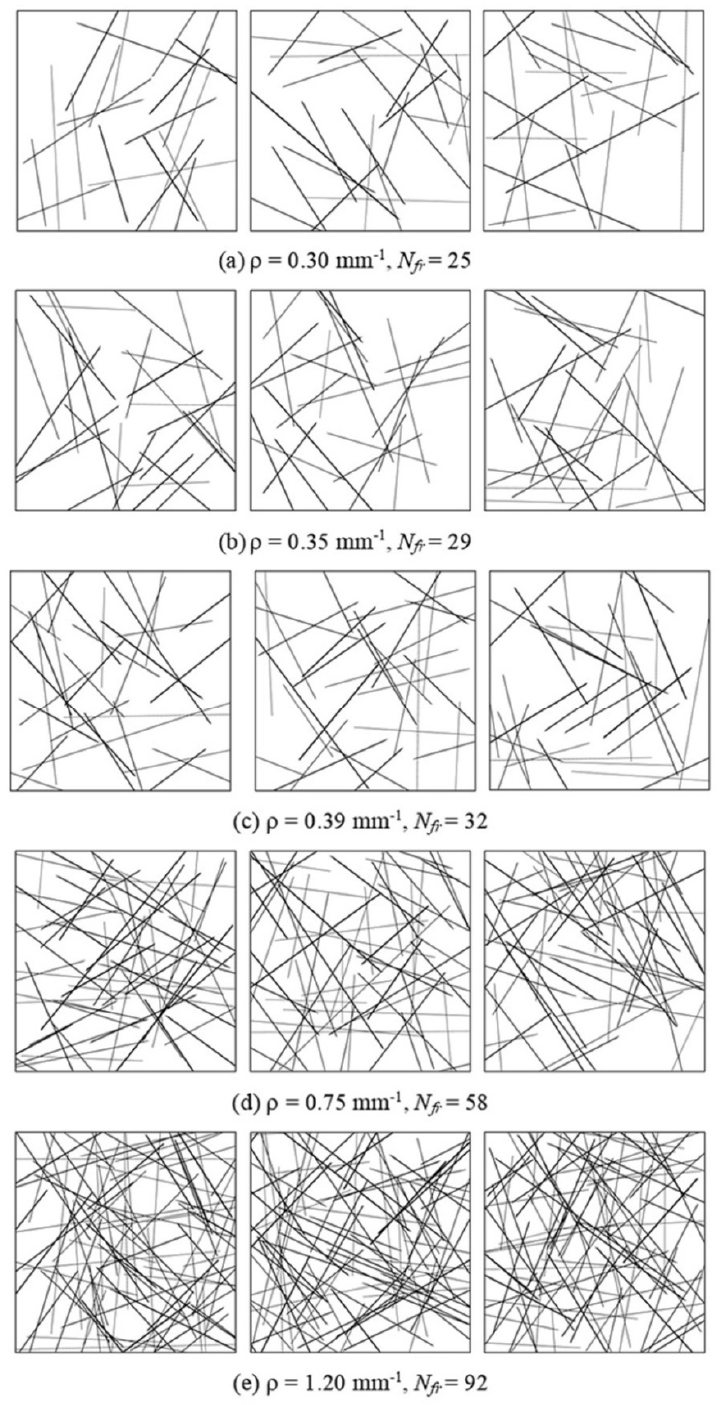
Figure 2. Connected fracture networks with various fracture densities and fracture numbers.